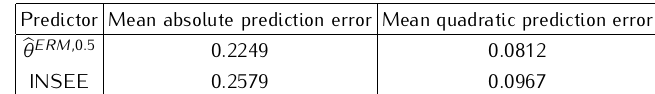
Table 1. Performances of the ERM and of the INSEE.